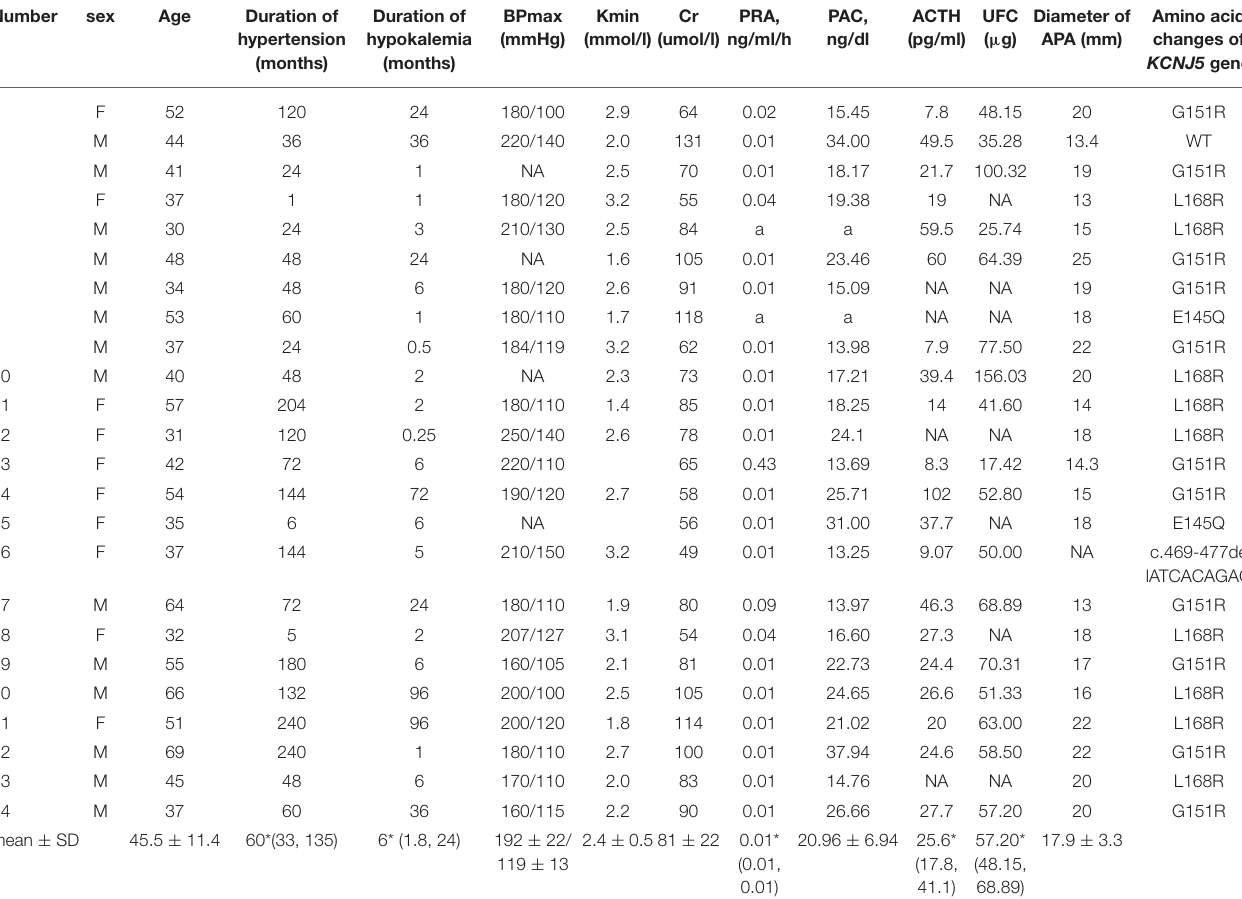
TABLE 1 | Clinical and genetic features of APA patients in in vitro